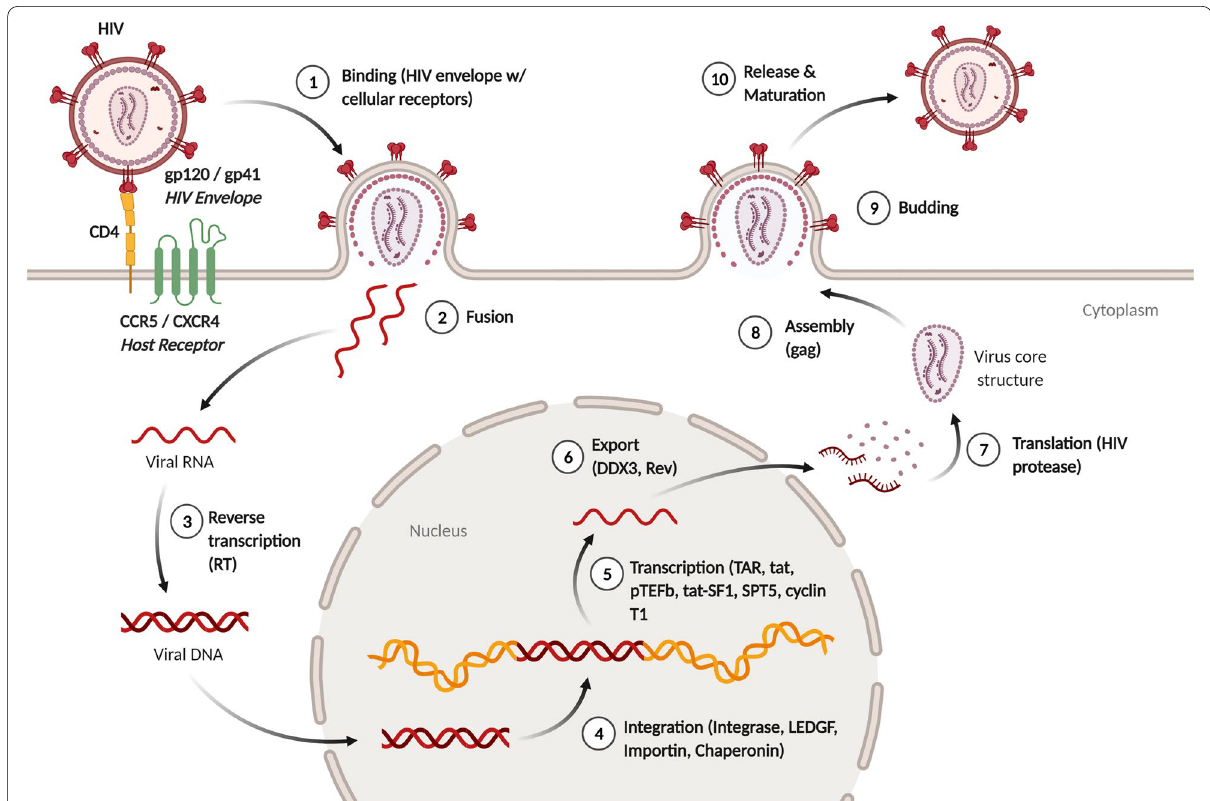
Fig. 2 HIV-1 replication cycle. The replication cycle involves several mechanisms where the HIV virus binds with the host receptor and inserts the viral RNA inside the host cells. Reverse transcriptase is used to synthesize viral DNA which would be integrated and transcribed inside the nucleus. Afterward, the mechanism is continued by a post-translational modification within the ribosome which would result in a complete viral structure. The complete viral structure is now ready to be assembled and released from the cell to weaken the body’s immune response and lead to the onset of AIDS. Some viral factors are necessary for these processes, including trans-activation response element (TAR) and trans activator of transcription (tat). Not to mention that several host factors also help these processes, such as positive transcription elongation factor B (pTEFb), tat-specific factor 1(tat-SF1), a transcription factor encoded by SUPT5H (SPT5), lens epithelium-derived growth factor (LEFDGF), dead box RNA helicase (DDX3), and regulator expression of virion